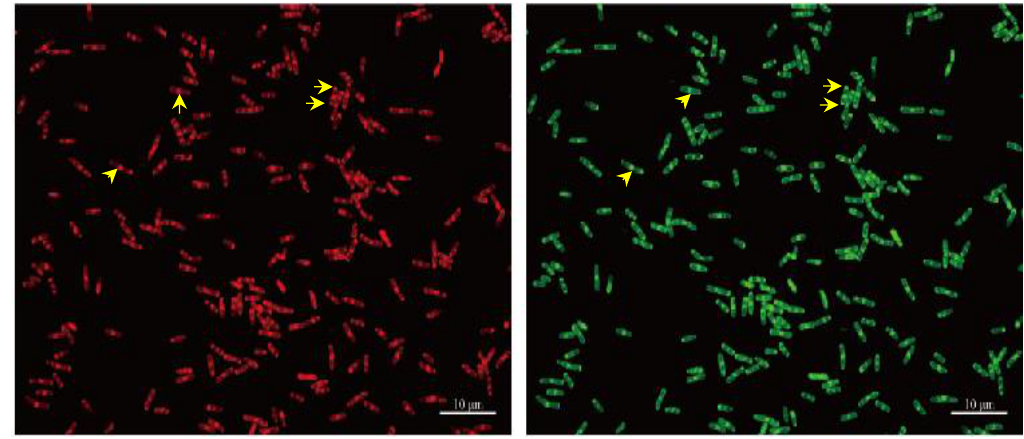
Figure 7. Fluorescence microscopy images of B. subtilis stained with PEG 6000 /CDs. Cells were stained with the concentrations of PEG 6000 /CD at 100 ppm. TRITC filter detected red color, while FITC filter detected green color. Scale bar represents 10 μm. Yellow arrows point to cell septa and cell poles.